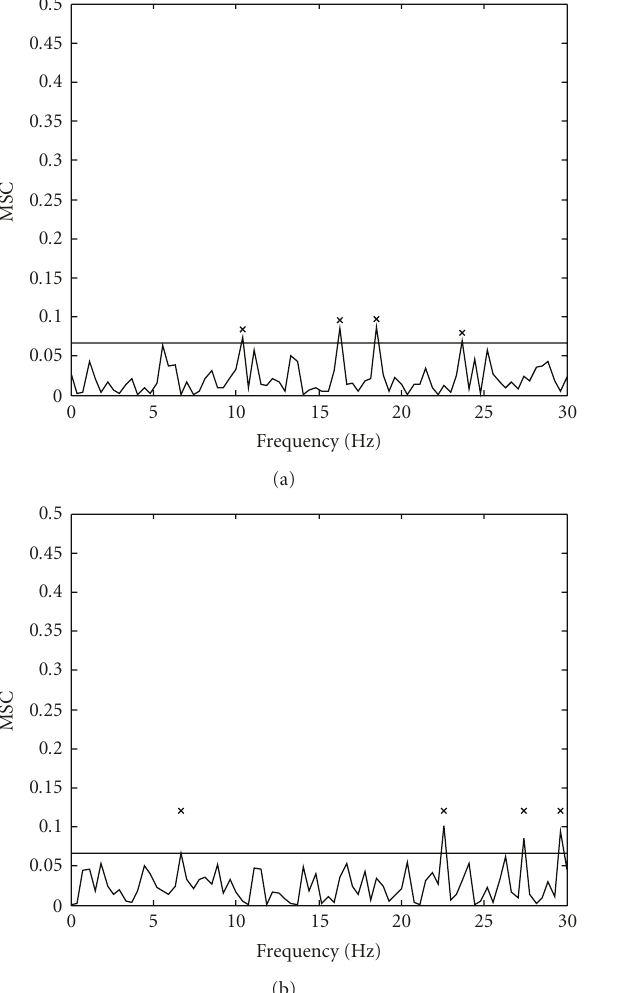
Figure 6: MSC ( M = 45) for subject #10’s spontaneous EEG at Cz channel with (a) unlighted LEDs and (b) lighted LEDs. The critical value (MSC critic = 0 . 0658, for α = 5%) is represented by the horizontal line. Similar behavior found frequencies higher than 30Hz.